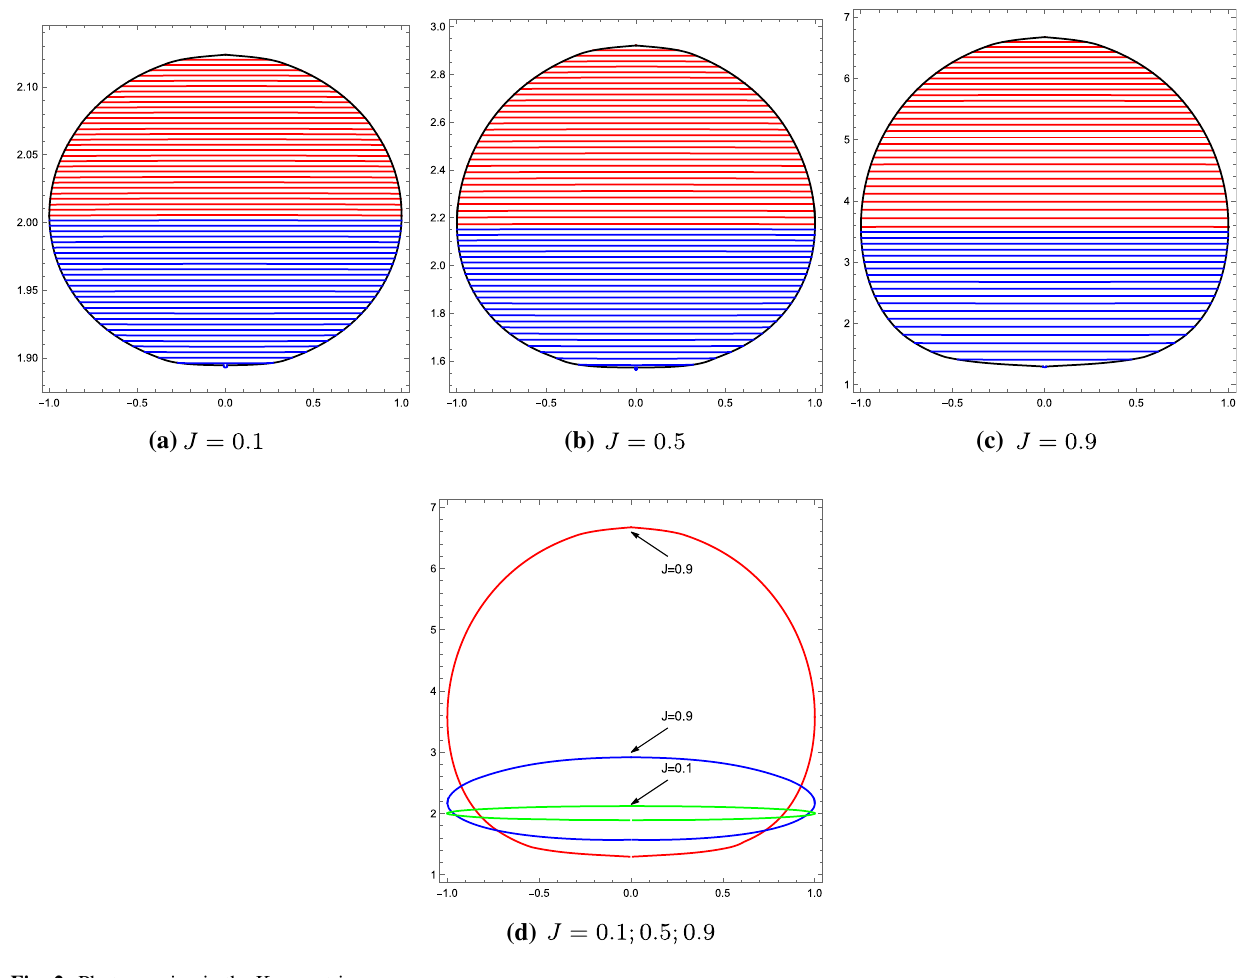
Fig. 2 Photon region in the Kerr